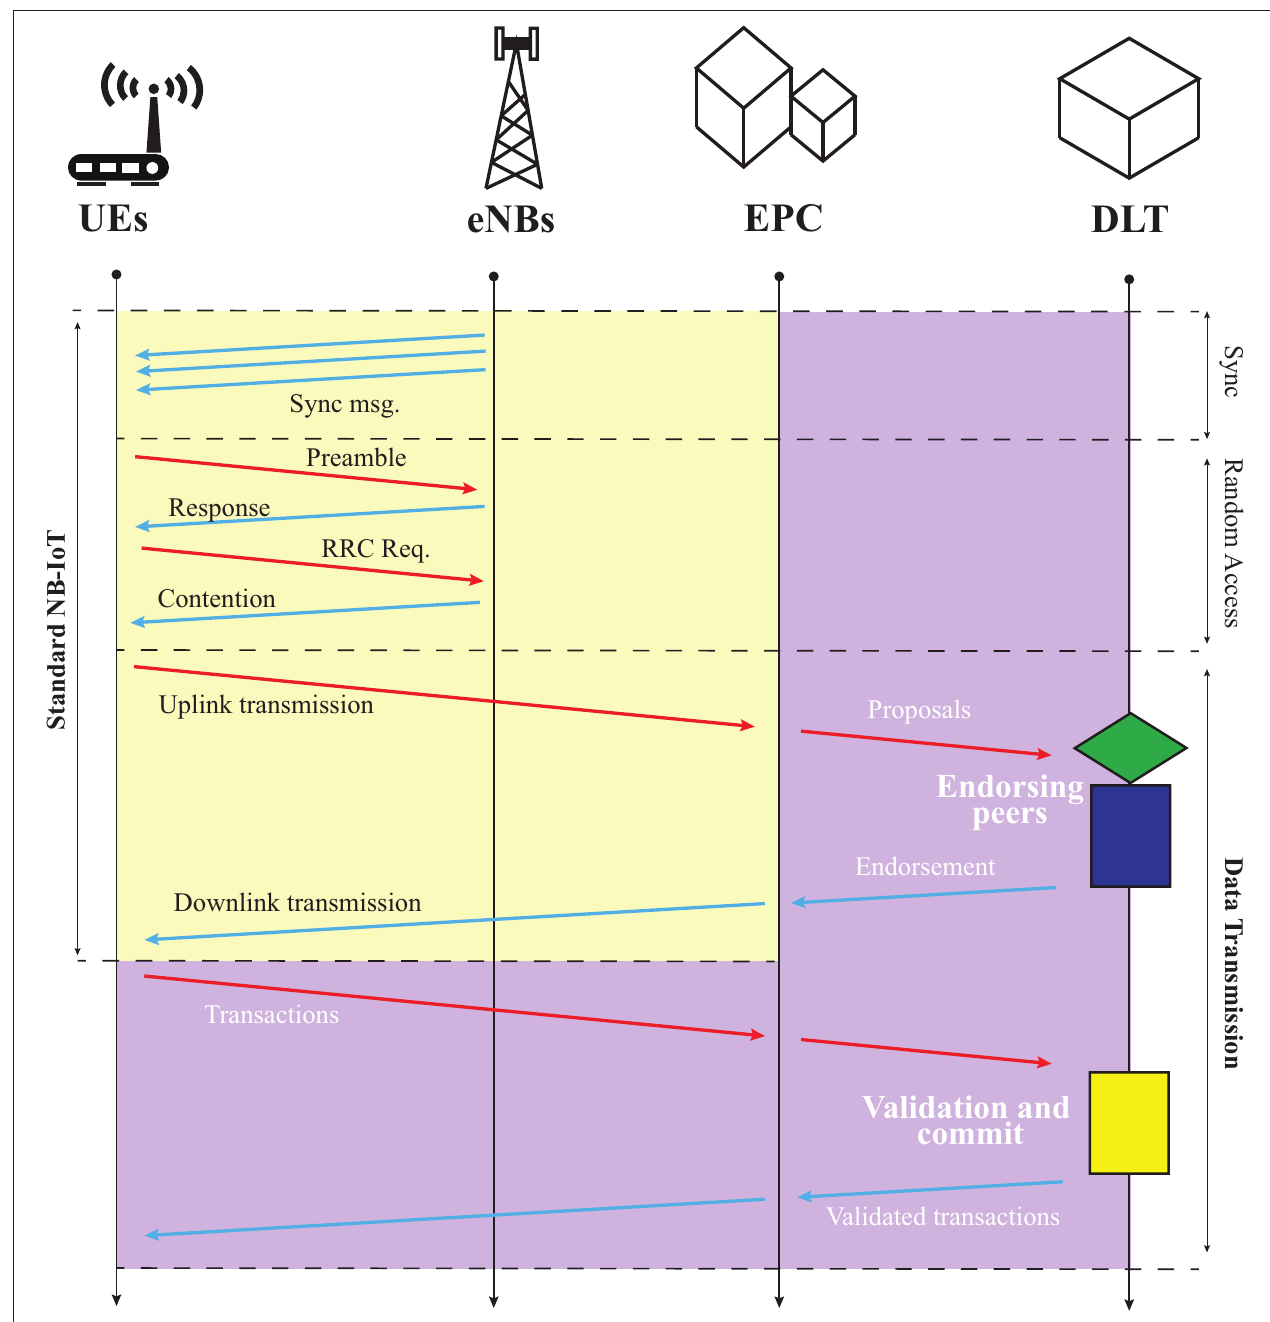
FIGURE 2 | Data workflow in both scenarios: standard NB-IoT in yellow background, which is complemented by the DLT-based system in purple background.